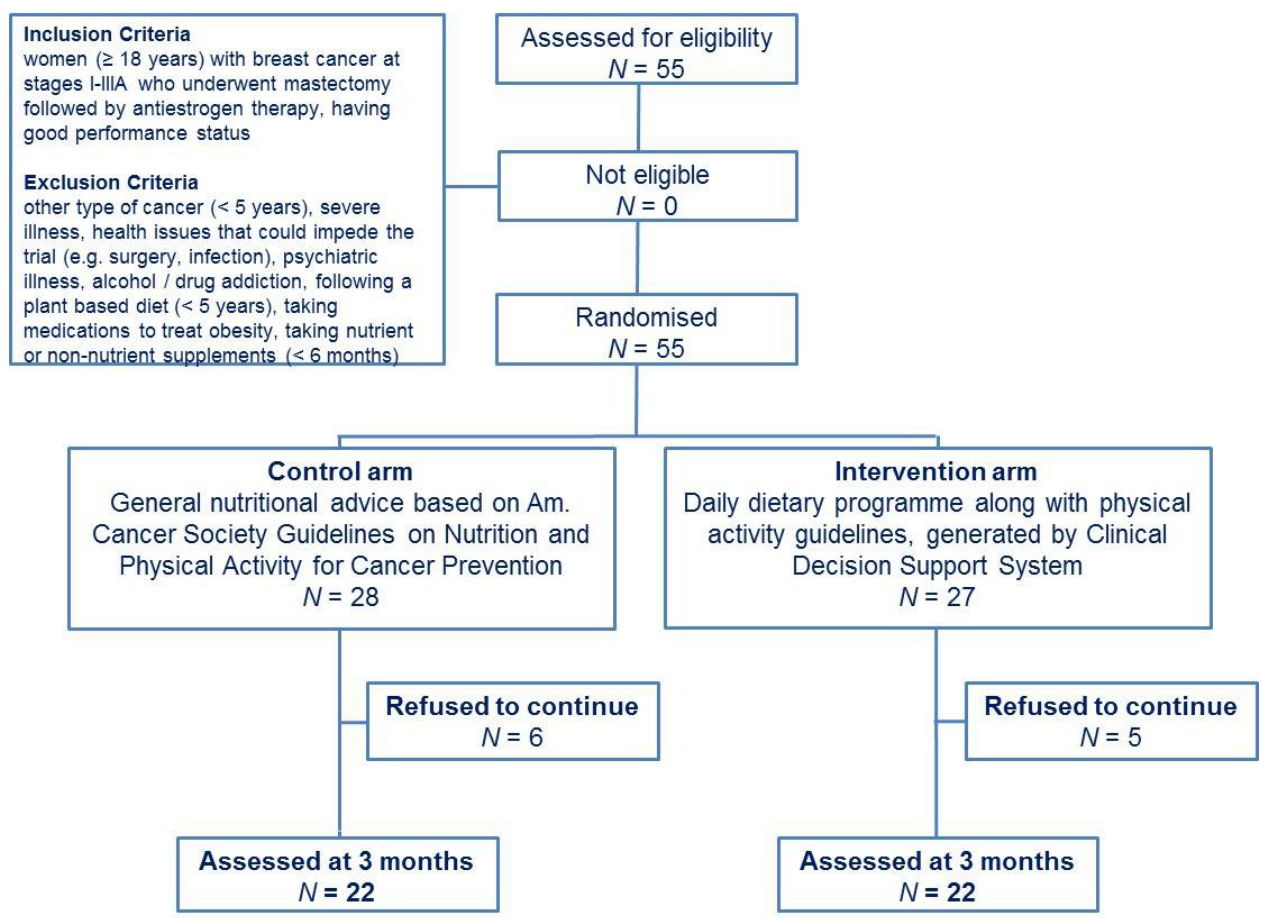
Figure 1. Trial workflow.